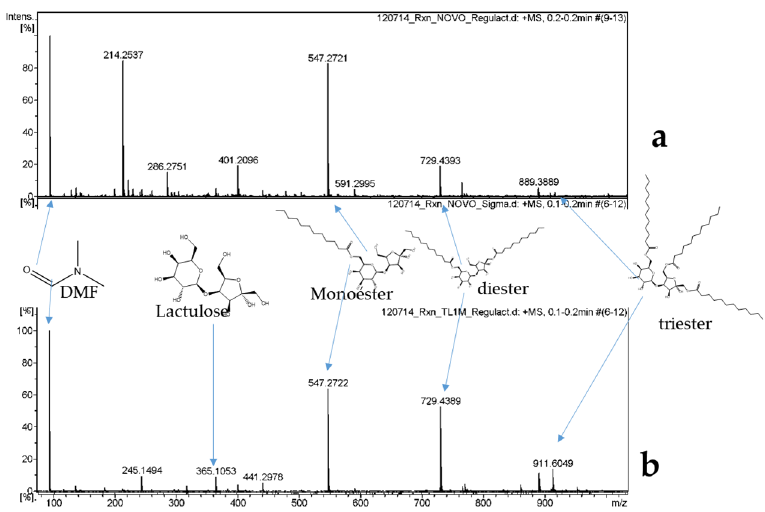
Figure 5. ESI graphs of the complete reaction of: ( a ) Novozym 435; ( b ) Lipozyme TL IM.